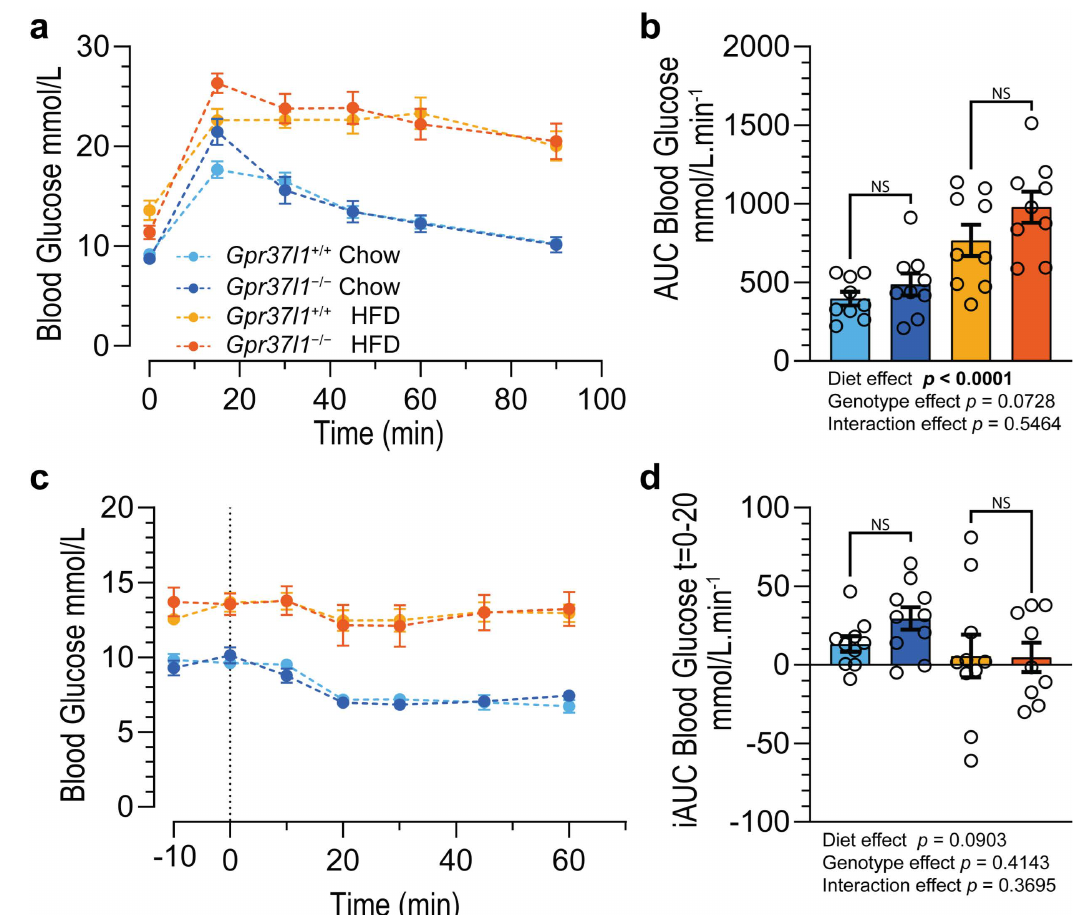
Figure 3. Glucose and insulin tolerance in Gpr37l1 − / − and Gpr37l1 +/+ mice fed chow or high-fat diet. All mice in the cohort 1 group were subjected to a glucose tolerance test (GTT) and an insulin tolerance test (ITT) following a 12-week period of either chow or high-fat diet (HFD). ( a ) During the GTT, an intraperitoneal glucose bolus (2 g glucose per kg of lean mass) was administered to Gpr37l1 − / − and wildtype ( Gpr37l1 +/+ ) littermates, and blood glucose was recorded immediately prior to glucose administration ( t = 0 min) and periodically for 90 min afterwards. ( b ) Response was quantified using area under the curve (AUC) analysis after subtraction of basal blood glucose level for each mouse. ( c ) During the ITT procedure, blood glucose was measured twice prior to intraperitoneal insulin administration (1 U per kg of lean mass) at t = 0 min. ( d ) Drop in blood glucose following insulin was quantified using an inverse AUC (iAUC) analysis by subtracting the t = 0 glucose value from all timepoints, then calculating AUC between 0 and 20 min. Solid circles and histograms indicate mean; error bars indicate SEM. Open circles represent individual subject values. Data (( b , d ) only) analysed by two-way ANOVA with Bonferroni post hoc test. Significance was defined as p < 0.05 and denoted by bolded p value; NS denotes non significance. GTT: n = 9 all groups. ITT: n = 9–10 for all groups, 20–21 weeks